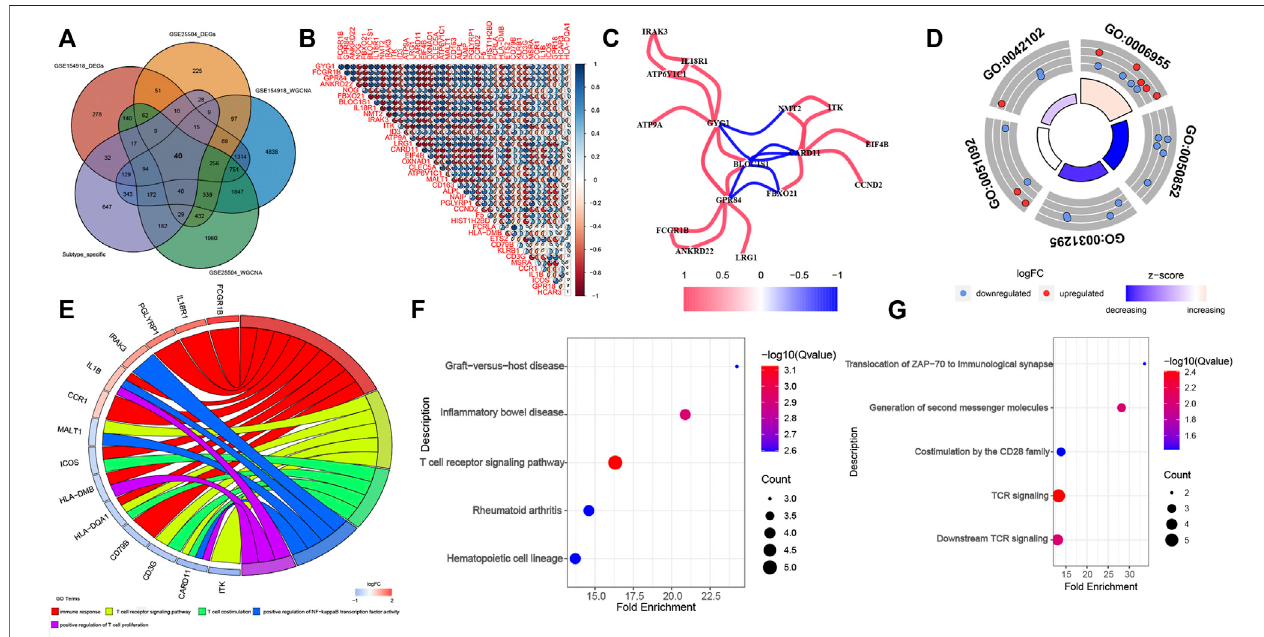
FIGURE 6 | Identi fi cation of co-DEGs and screening enriched pathways related to co-DEGs. (A) Representative Venn diagram of intersection genes. (B) Representative correlation coef fi cient heat map of 40 co-DEGs. (C) Representative diagram of gene relationship network with a correlation coef fi cient of more than 0.9. (D) The fi rst5GOenrichmentanalysis(BP)resultsofthe40co-DEGs. (E) Representativechordplotofthe fi rst5GOenrichmentanalysis(BP)resultsofthe40co-DEGs. (F,G) The top 5 KEGG (F) and Reactome (G) enrichment analysis results of the 40 co-DEGs.